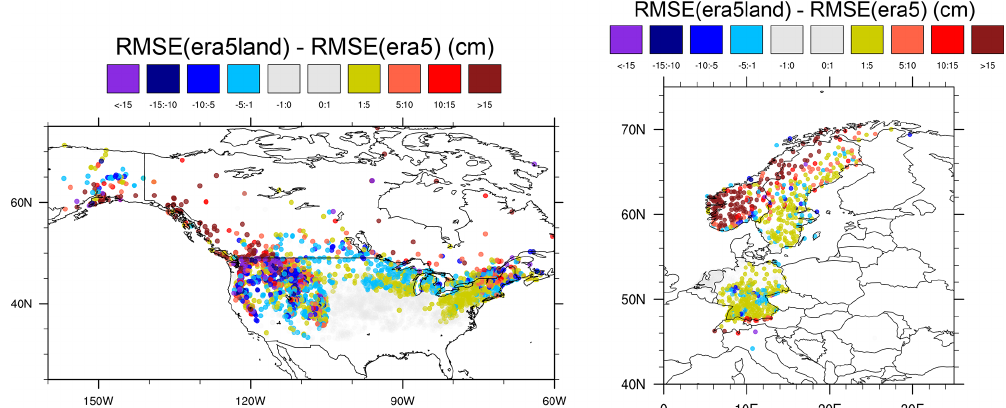
Figure 9. Snow depth RMSE difference between ERA5-Land and ERA5 (with respect to GHCN observations) for the months of December to June between 2010 and 2018. Negative values indicate better matching of ERA5-Land averaged snow depth with in situ measurements of the GHCN network; positive values indicate that ERA5 averaged snow depth estimates are matching better in situ measurements.